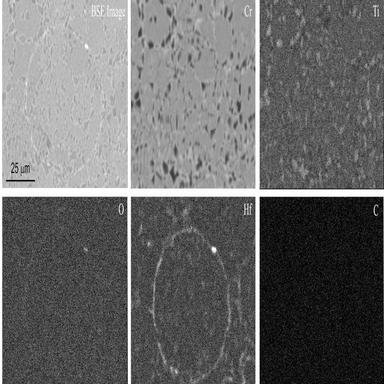
Electron probe microanalysis elemental scan maps along with the BSE image.